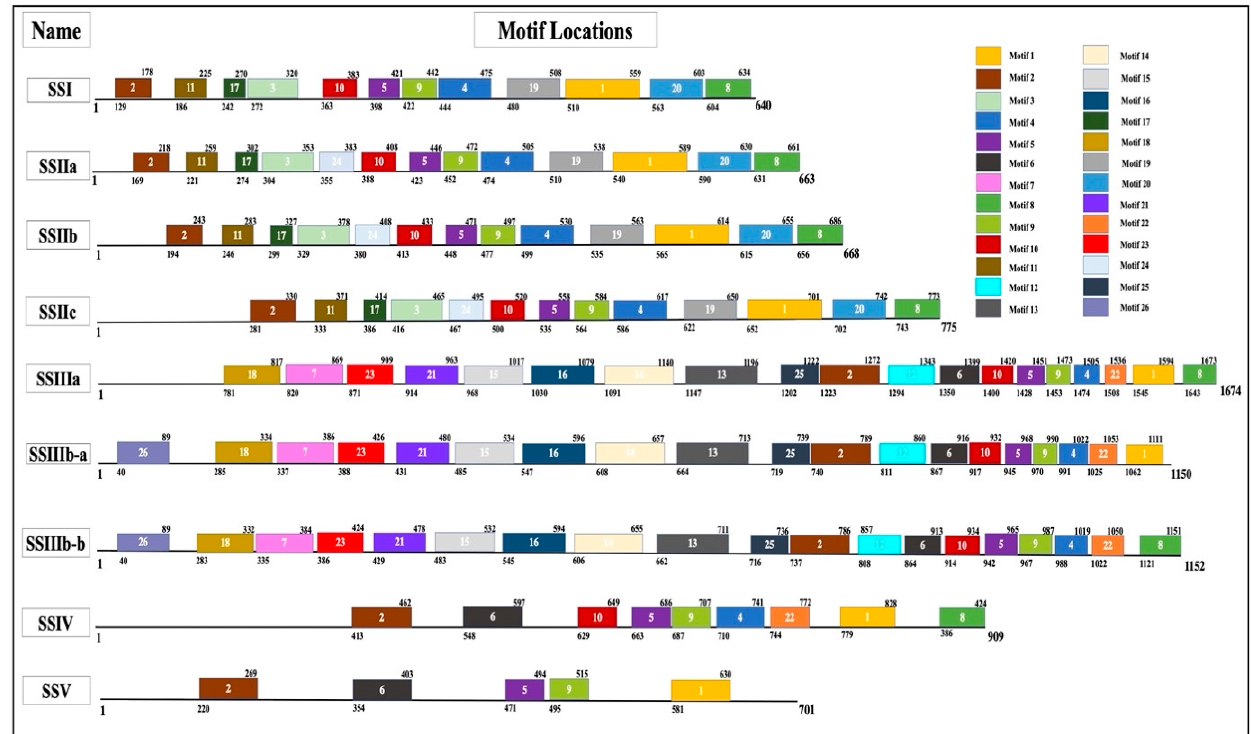
Figure 4. Conserved motifs of Starch synthase proteins. Zea mays motifs are shown as example. All sequences were analyzed through MEME to discover conserved patterns.